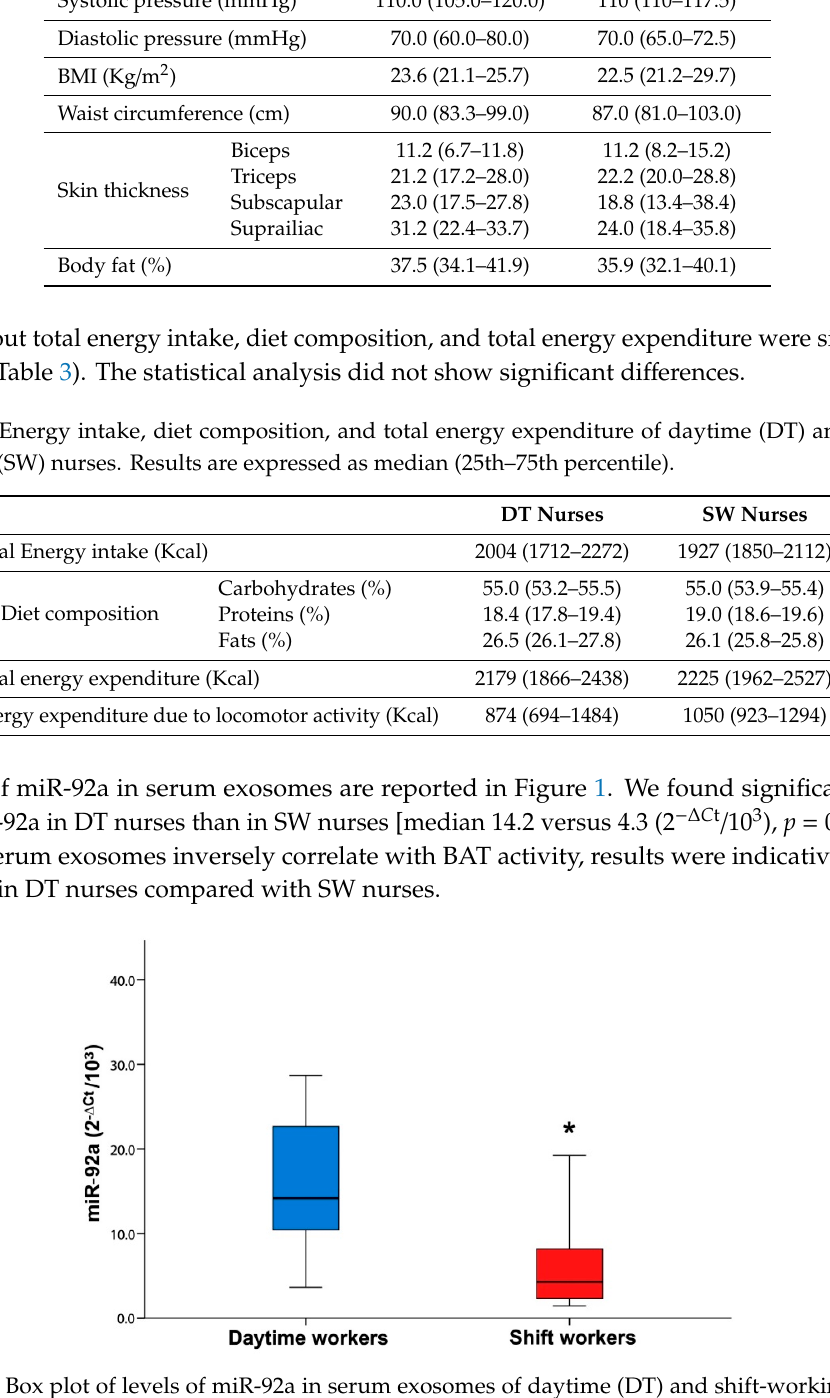
Figure 1. Box plot of levels of miR-92a in serum exosomes of daytime (DT) and shift-working (SW) nurses. * p < 0.05, Mann-Whitney U test.